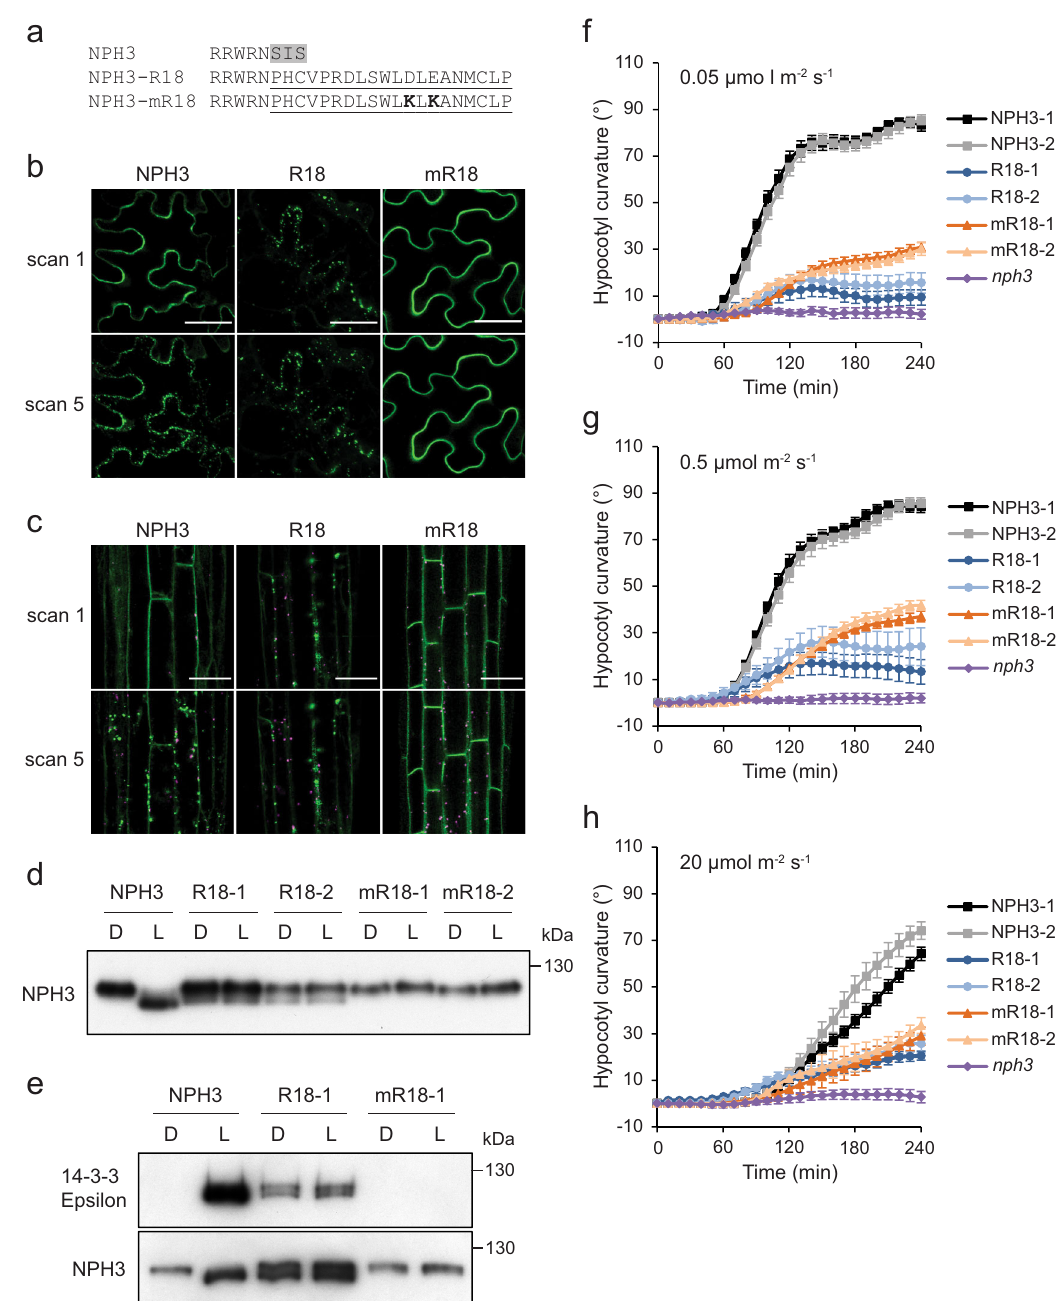
Fig. 7 Analysis of a constitutive 14-3-3 binding NPH3 variant. a Amino-acid sequence of the NPH3-R18 and mR18 constructs. Residues 744 – 746 of NPH3 (grey shaded) were replaced with the R18 peptide sequence (underlined). Two lysine residues (bold) were introduced into the mR18 sequence to abolish 14- 3-3 binding. b , c Confocal images of GFP-NPH3 (NPH3), GFP-NPH3 containing the R18 peptide sequence (R18) or the mutated R18 peptide sequence (mR18) ( b ) transiently expressed in leaves of N. benthamiana plants, dark-adapted before confocal observation and ( c ) in hypocotyl cells of etiolated transgenic Arabidopsis nph3 seedlings. Images were acquired immediately (scan 1) and after repeat scanning with the 488 nm laser (scan 5). GFP is shown in green and auto fl uorescence in magenta. Bar, 50 µ m. These experiments were repeated at least twice with similar results. d Immunoblot analysis of total protein extracts from etiolated nph3 seedlings expressing NPH3, R18 or mR18 maintained in darkness (D) or irradiated with 20 µ mol m − 2 s − 1 blue light for 15min (L). Protein extracts were probed with anti-NPH3 antibodies. This experiment was repeated twice with similar results. e Far-western blot analysis of anti-GFP immunoprecipitations from etiolated nph3 seedlings expressing NPH3, R18 or mR18 maintained in darkness (D) or irradiated with 20 µ molm − 2 s − 1 of blue light for 15 min blue light (L). GST-tagged 14-3-3 isoform Epsilon was used as the probe. Blots were probed with anti-NPH3 antibody as a loading control (bottom panel). Phototropism of etiolated nph3 seedlings expressing GFP-NPH3 (NPH3), R18 or mR18 and nph3 mutant seedling irradiated with value is the mean ± SE of 18 – 20 seedlings from two independent biological replicates. Exact n values are provided in the Source data fi